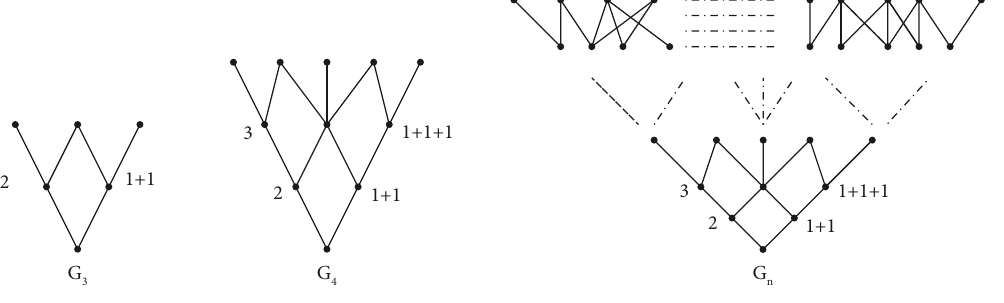
Figure 4: Position of vertices of degree 3.